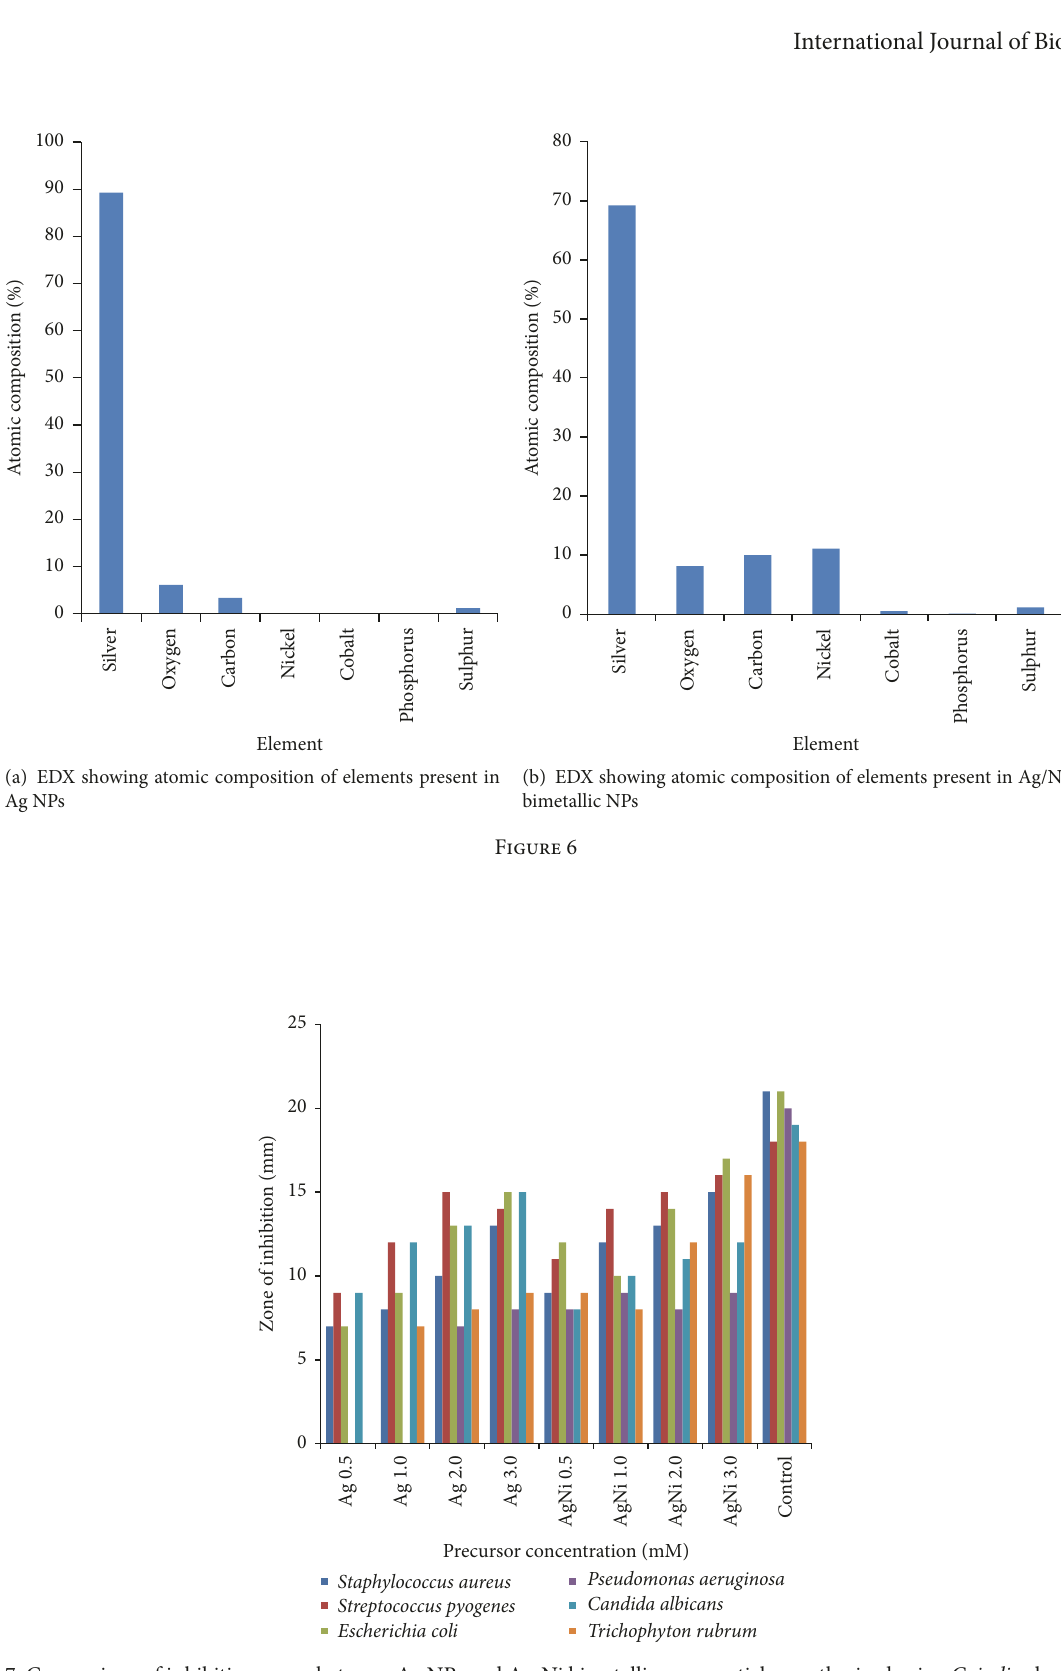
Figure 7: Comparison of inhibition zones between Ag NPs and Ag-Ni bimetallic nanoparticles synthesized using C. indica leaf